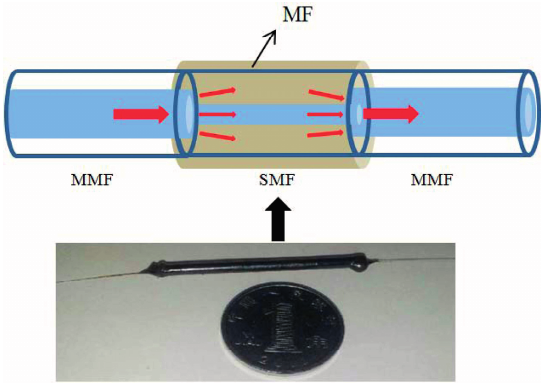
Figure 1. Schematic of the multimode-singlemode-multimode (MSM) structure. The low panel shows the experimental